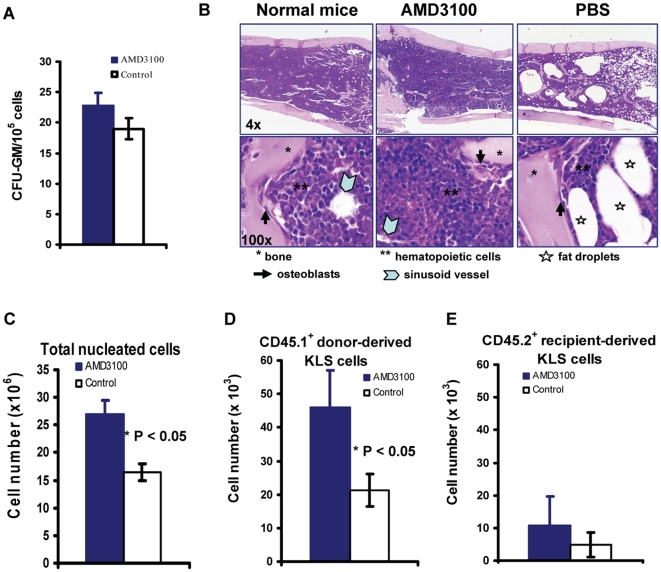
Post transplant administration of AMD3100 enhances donor cell marrow engraftment.The mice as described in
Fig. 1
 were sacrificed at Day +65 post transplantation, and 2 femurs and 2 tibias were harvested and processed and analyzed as described in Methods. A: CFU-GM assay. CFU-GM colonies were measured in individual mice using MethoCult® GF 3434 mouse colony-forming cell assay. B: Histology. Bone marrow from individual mouse was examined by microscopy (4X: top panel and 100X: bottom panel) after decalcification and H/E staining. Trabecular bony structure, osteoblasts, hematopoietic cells, sinusoid vessels and acellular areas filled with lipid droplets were indicated. Normal mice did not receive transplant or AMD3100 injection. C: Total nucleated cell number from 1 femur and 1 tibia. D: Donor-derived CD45.1+ KLS stem cell number from 1 femur and 1 tibia of individual mouse. E: Recipient-origin CD45.2+ KLS stem cell number from 1 femur and 1 tibia of individual mouse. *: p<0.05.